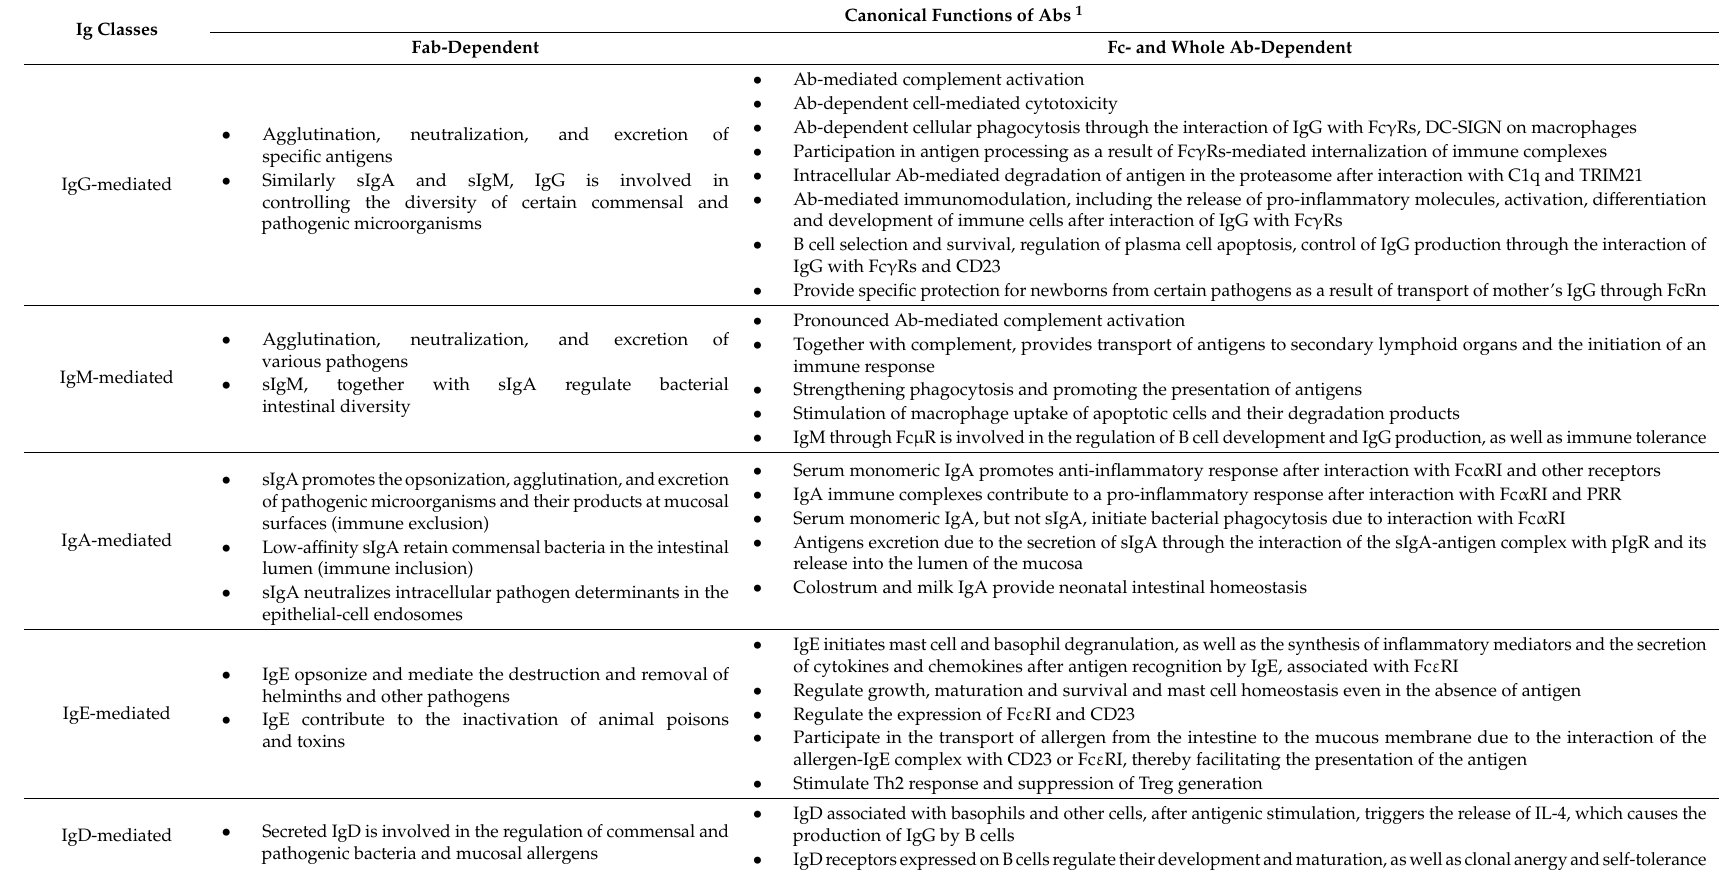
Table 1. The canonical and non-canonical functions of antibodies